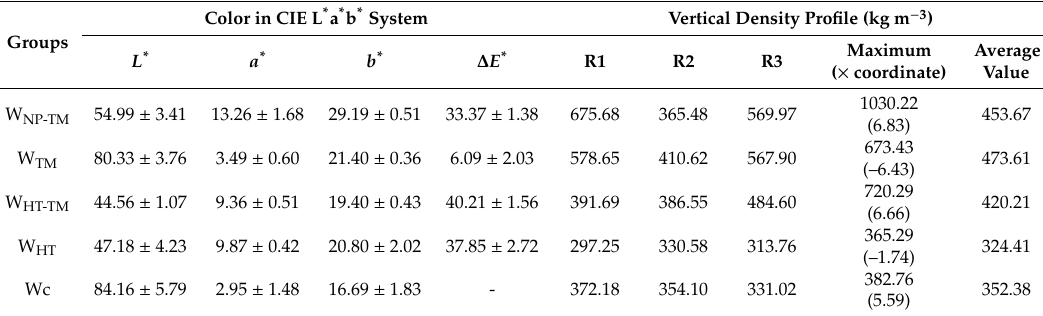
Table 2. Color in CIE L * a * b * system and density of the selected